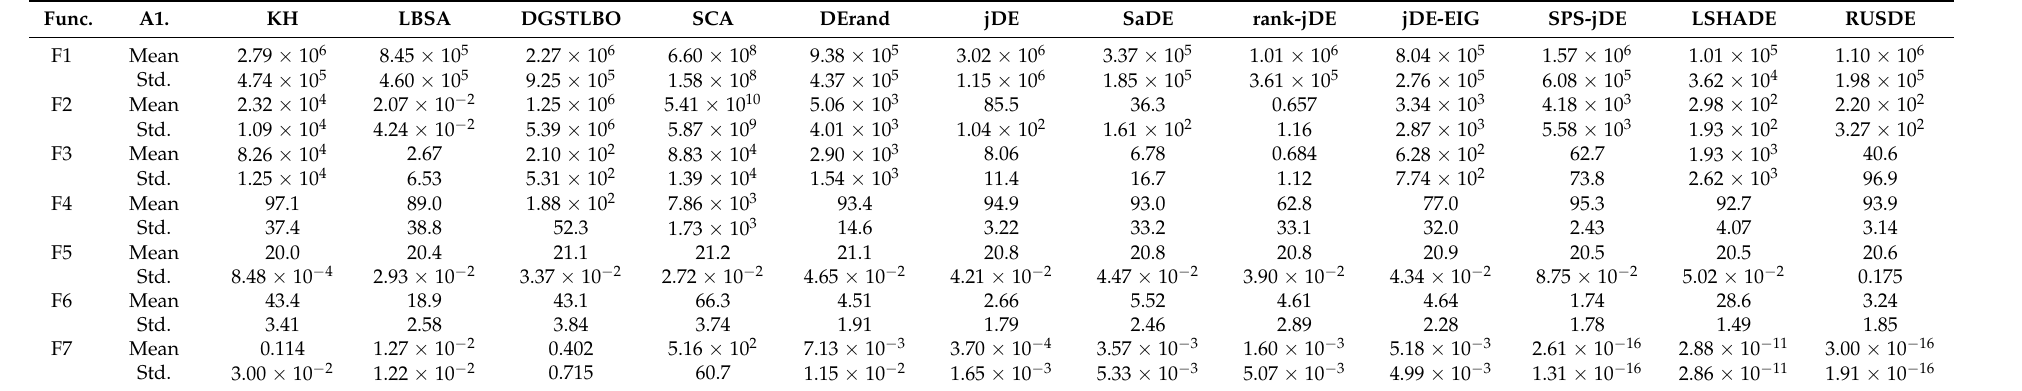
Table 3. The comparative results of 50-dimensional problems for CEC